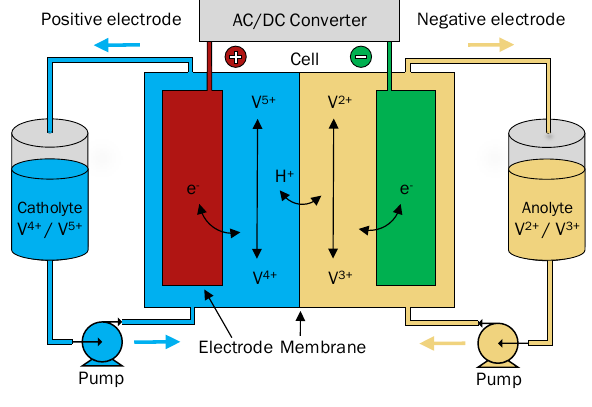
Figure 3. Vanadium Redox Flow